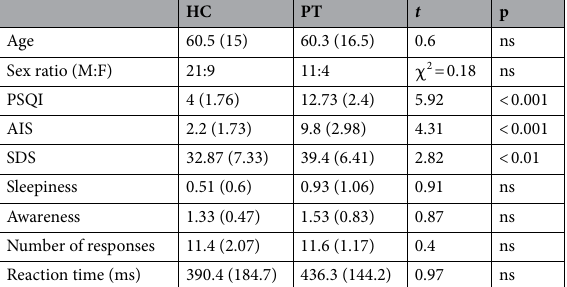
Table 1. Participant demographic data. All values are expressed as mean (SD). HC Healthy control group, PT Insomnia patient group, PSQI The Pittsburgh Sleep Quality Index, AIS Athens Insomnia Scale, SDS Self-Rating Depression Scale. Degrees of freedom (df) = 43.